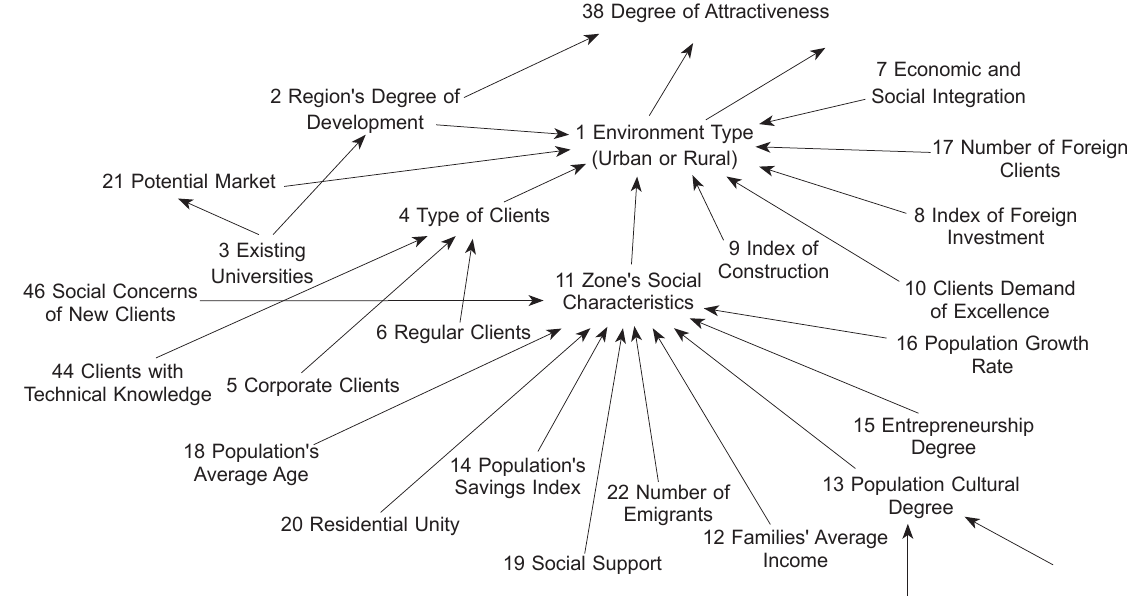
Figure 1. Part of the strategic